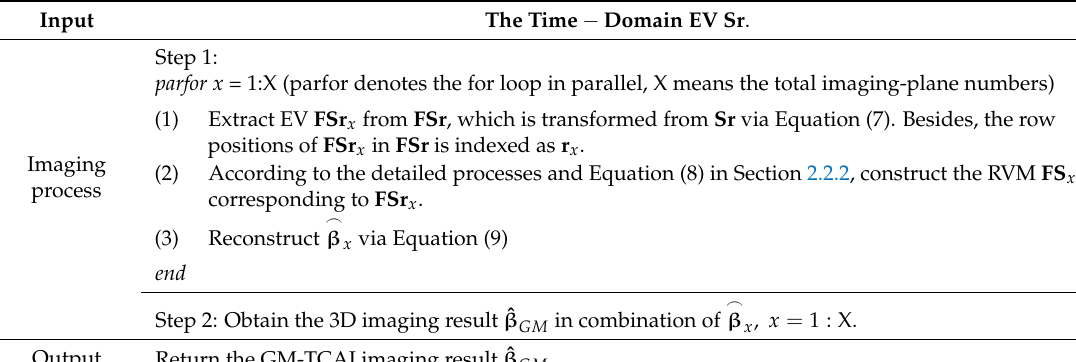
Table 2. Imaging procedure of geometric measures